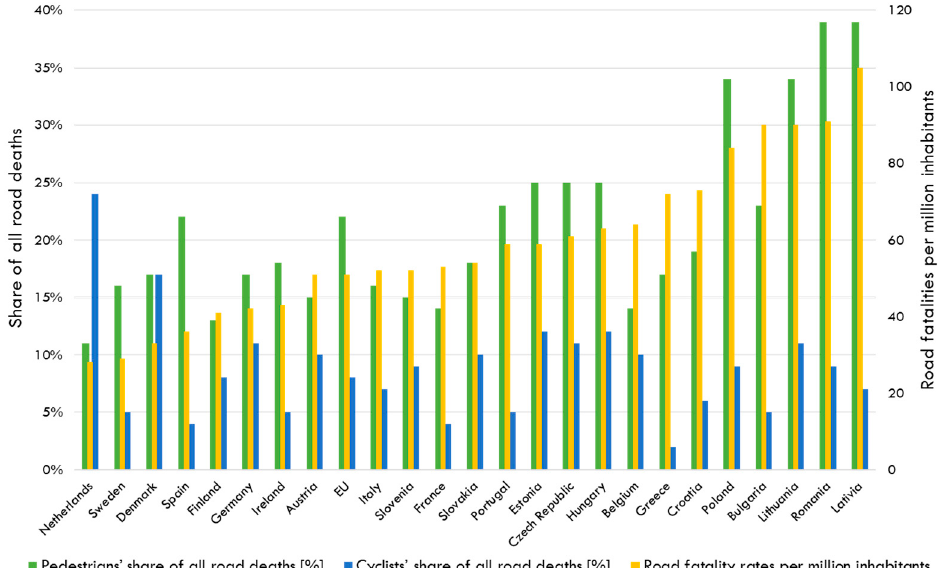
Figure 2. Pedestrians’ and cyclists’ share of all road deaths [%] in contrast to road fatality rates per million inhabitants [ ] in European Union in 2014—based on data from [9,12].